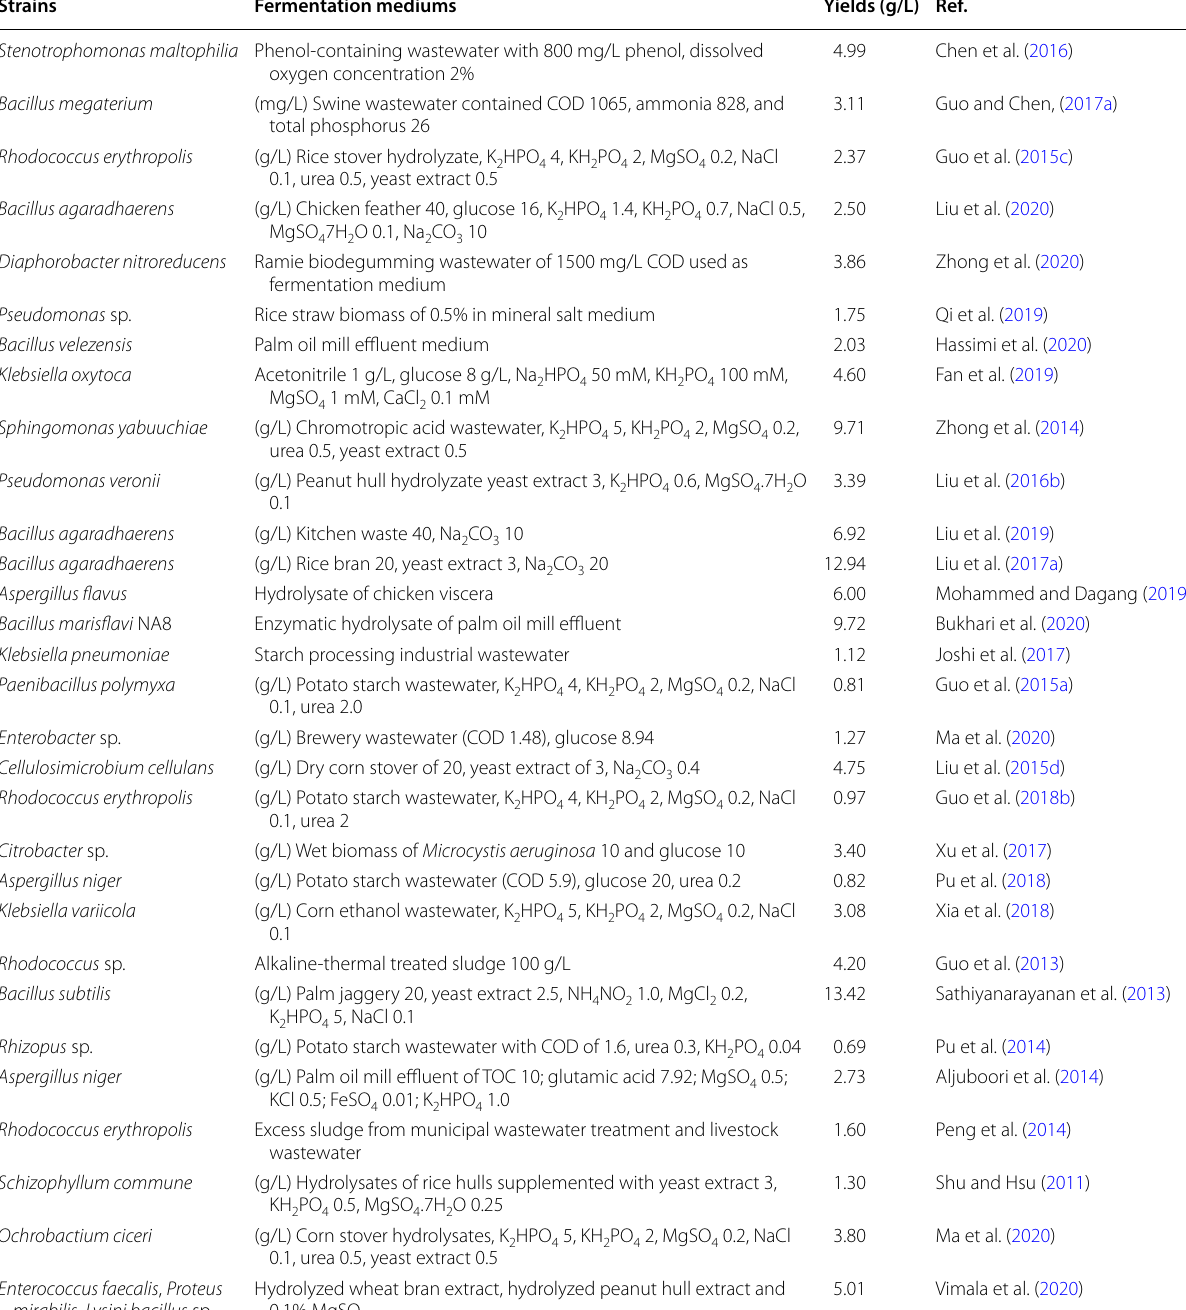
Table 4 Production of microbial flocculants using cheap wastes or waste waters as alternative